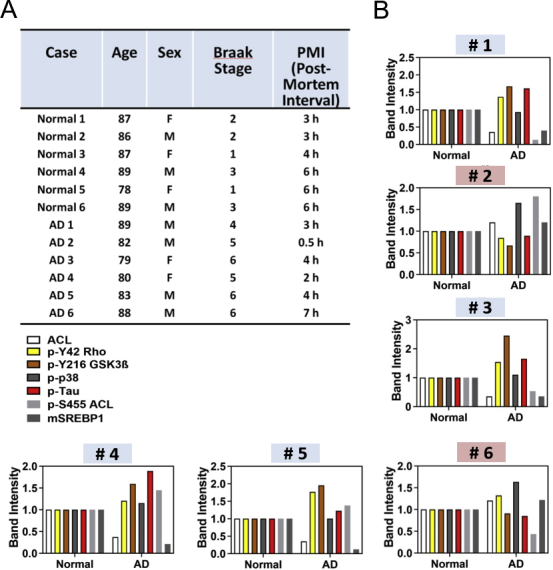
Assessment of brain tissues of AD patients. (A) Table of Information on postmortem brain tissue samples from temporal cortex of normal subjects and AD patients. (B) Quantification of Fig. 7B.